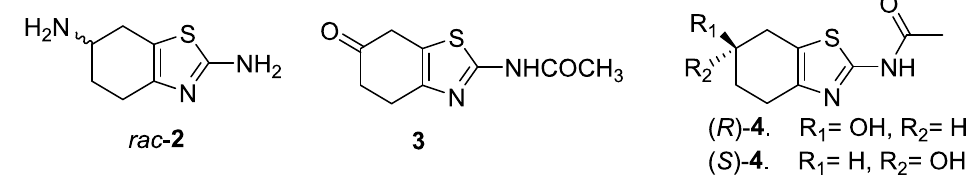
Figure 2. Structures of amine rac - 2 , ketone 3 , alcohol ( R )- 4 and its isomer ( S )- 4 .